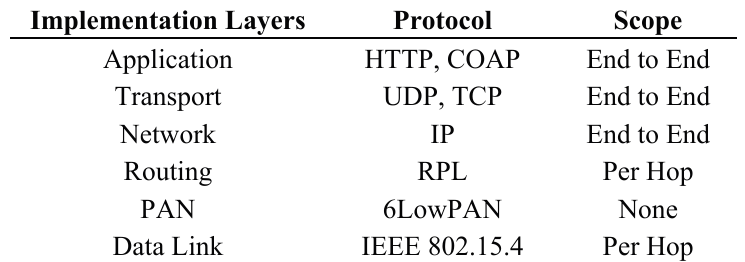
Table 3. Example implementation layers and protocols for a cyber-physical sensor network environment.